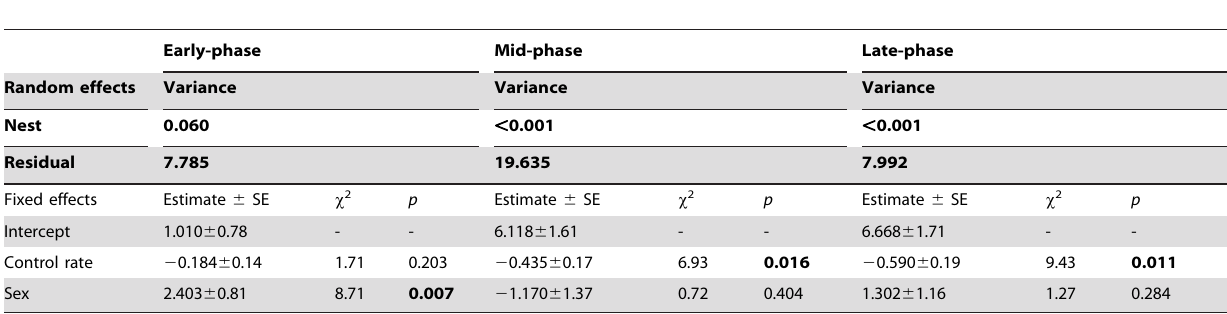
Table 2. Results of linear mixed effects models investigating the difference in provisioning rates of partners between the control period and period of playback to focal